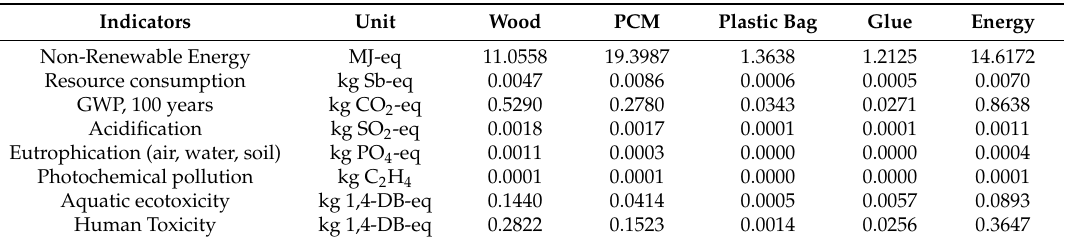
Table 6. Results of the SLCA Bilan Produit